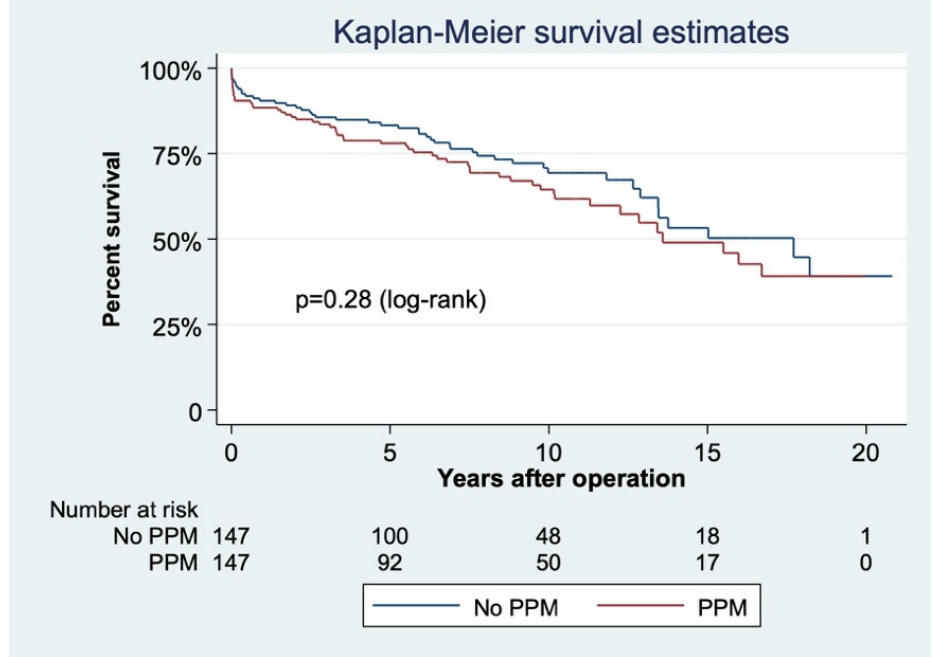
Figure 2. Cumulative survival in the matched cohort according to the presence of patient–prosthesis mismatch (EOAi ≤ 0.85 cm 2 /m 2 ).